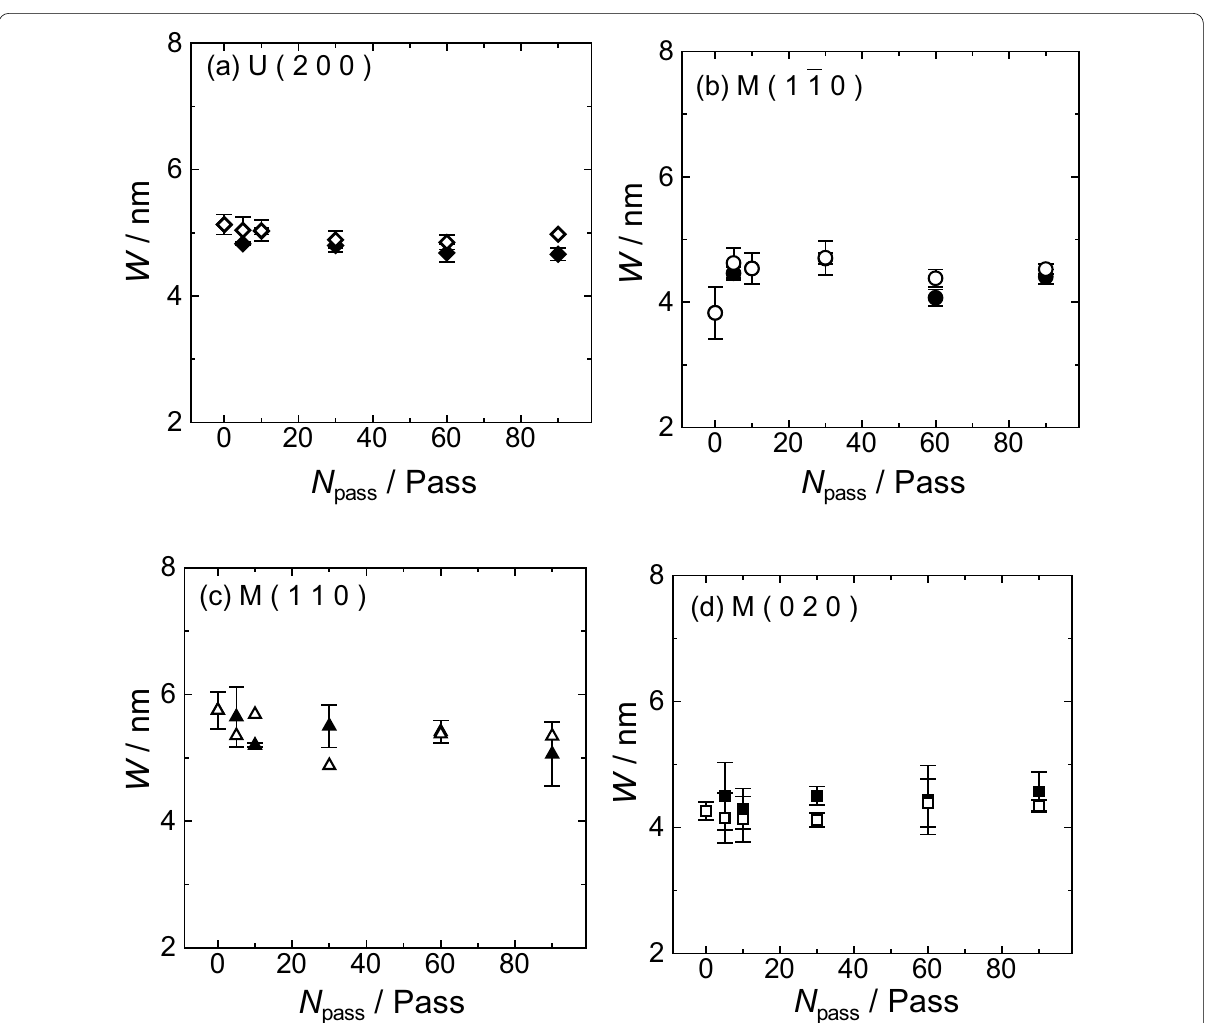
1 1 0 plane, c (1 1 0) plane, and (cid:31) (cid:30)